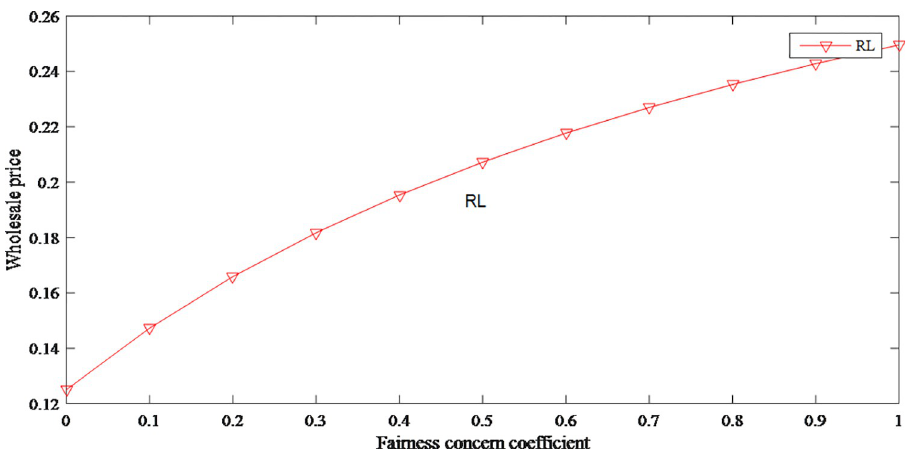
Fig 9. The impact of fairness concern on wholesale price.